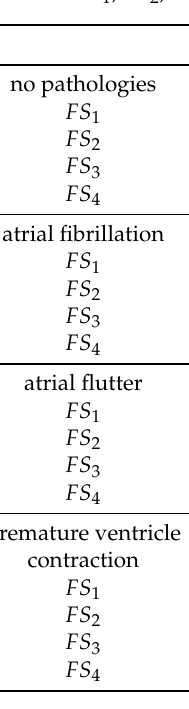
Table 5. FS 1 , FS 2 , FS 3 and FS 4 achieved for ECG s related to Case